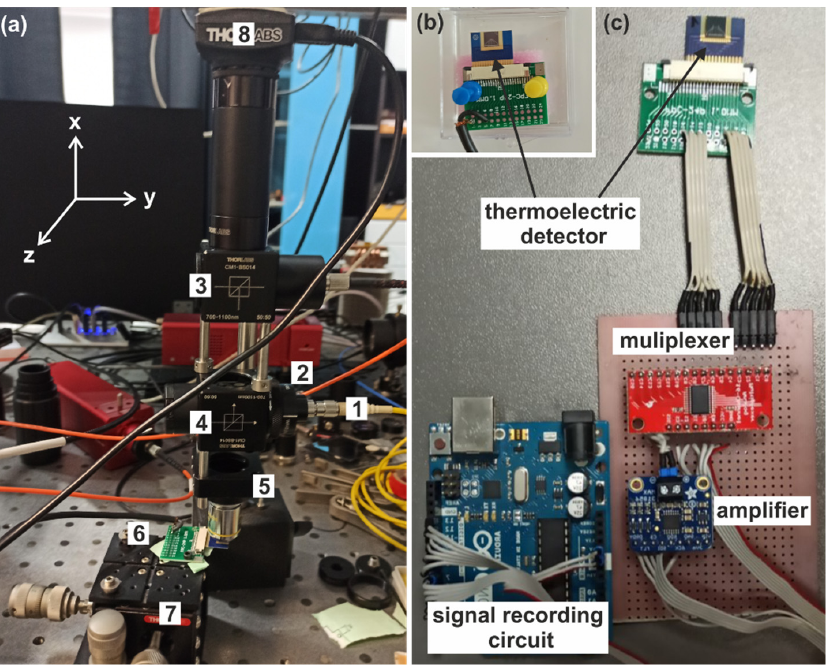
Figure 4. ( a ) The optical part of the experimental setup; ( b ) the configuration of the setup compo- nents to measure voltage output at a single thermocouple; and ( c ) the configuration of the setup components to measure voltage output at each available thermocouple